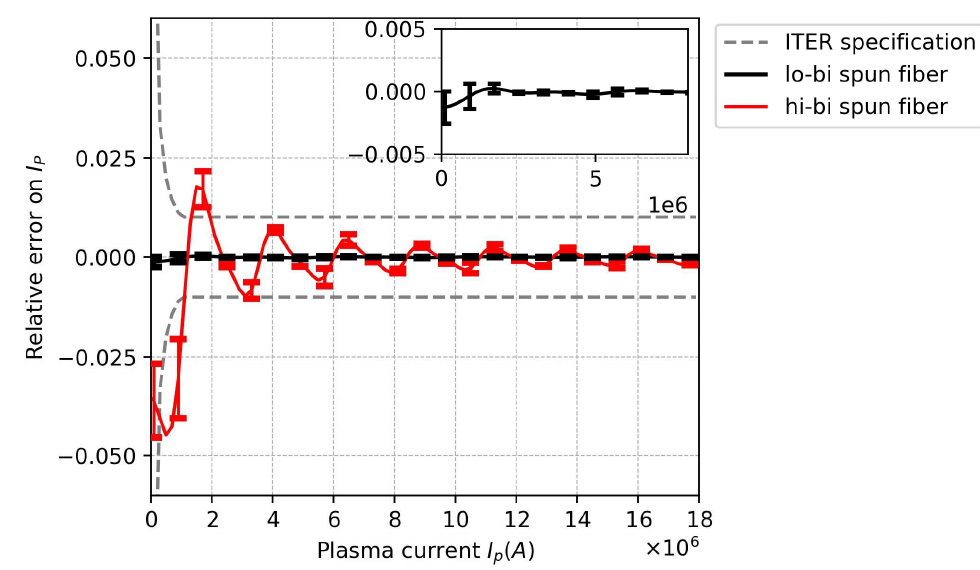
Figure 9. Simulation results for measurement error of FOCS, including the vibration effect for both spun fibers. Inset is magnification of the lo-bi spun fiber’s